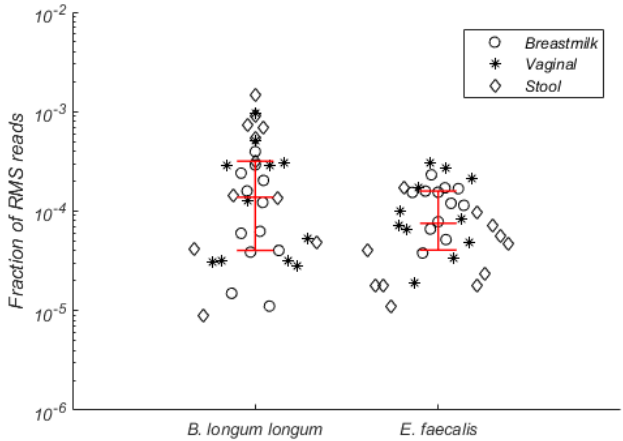
Figure 1. Fraction of RMS reads that belong to commonly detected RMS clusters identified as B. longum ssp. longum and E. faecalis. Median values, as well as 25th and 75th percentile, are depicted in red.